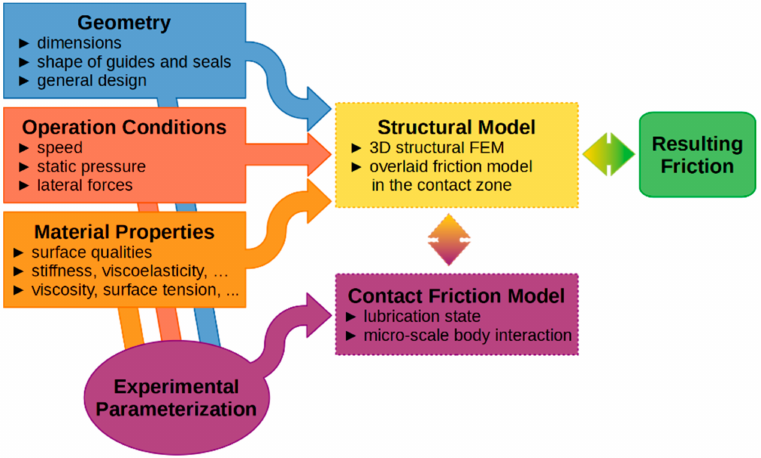
Figure 2. Solution approach overview; three main parameter groups are included in the simulation either directly or indirectly via experimental